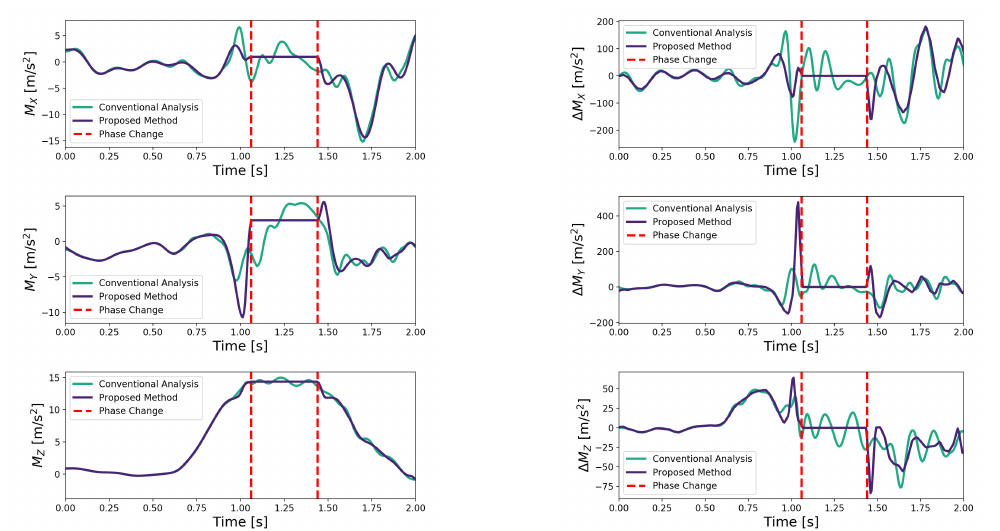
Figure 8. Angular Momentum and Change of Angular Momentum around the Center of Mass. Similar to Figure 7 we see constant values during the flight phase and zero values of the derivative for the proposed method. Values computed with the conventional method are not respecting Newtons EoM.